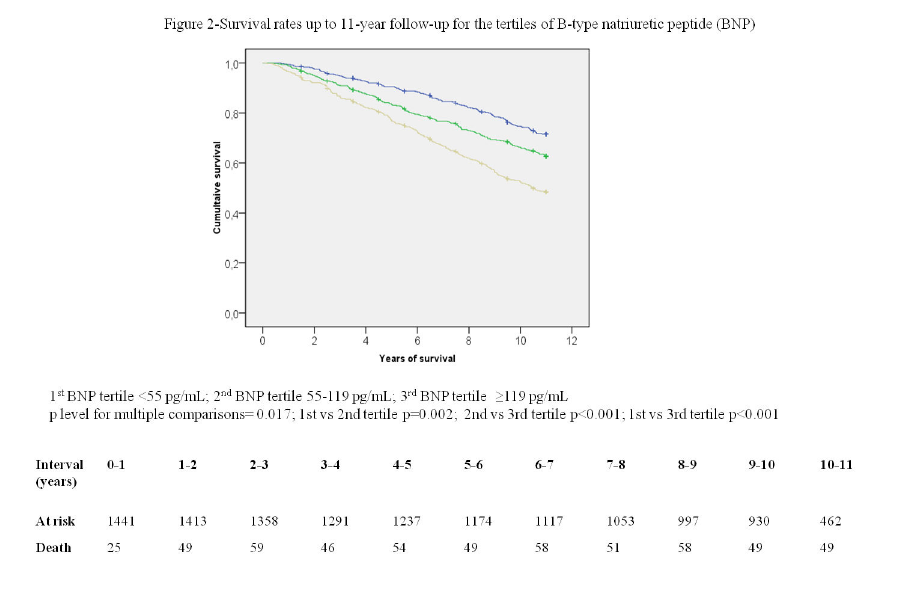
Figure 2. Survival rates up to 11-year follow-up for the tertiles of B-type natriuretic peptide (BNP).